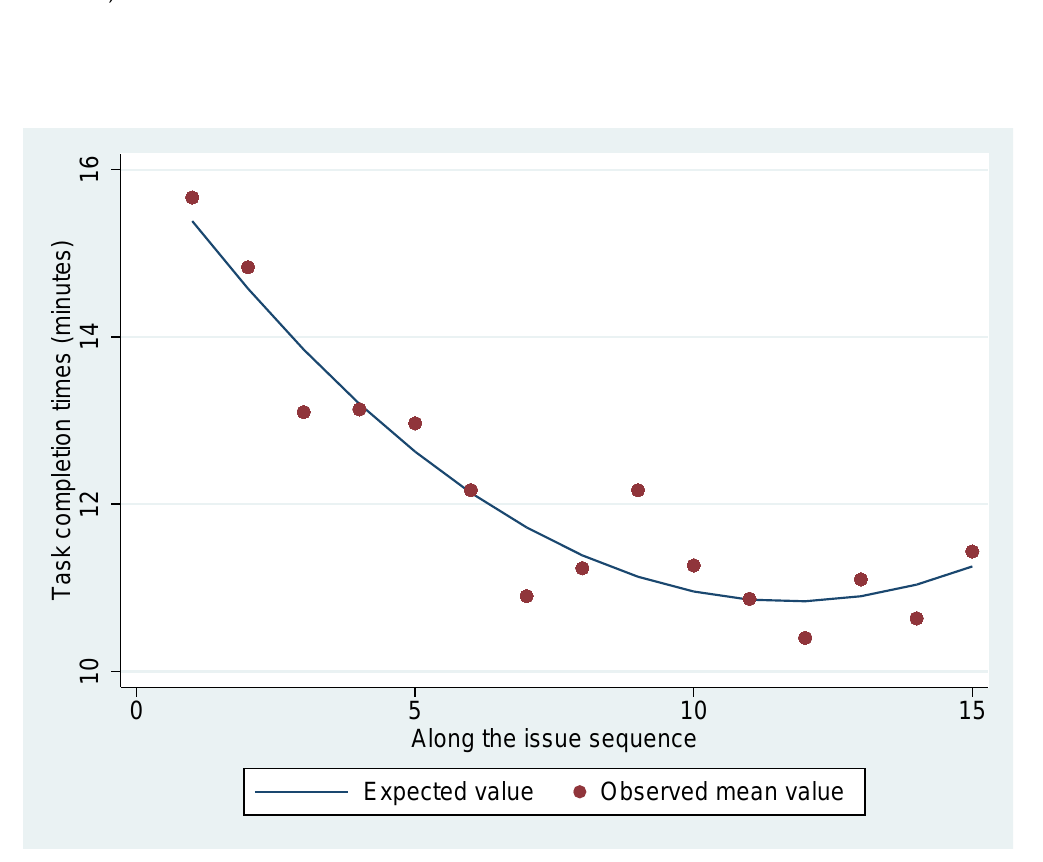
Figure 8: Trajectory of time to task completion along the issue sequence estimated from the model(a) estimates of Table